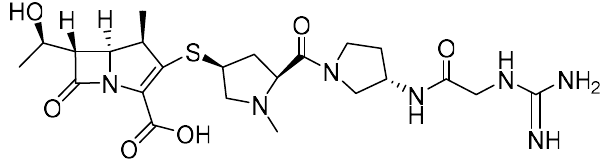
Figure 1. Chemical structure of CS-023.